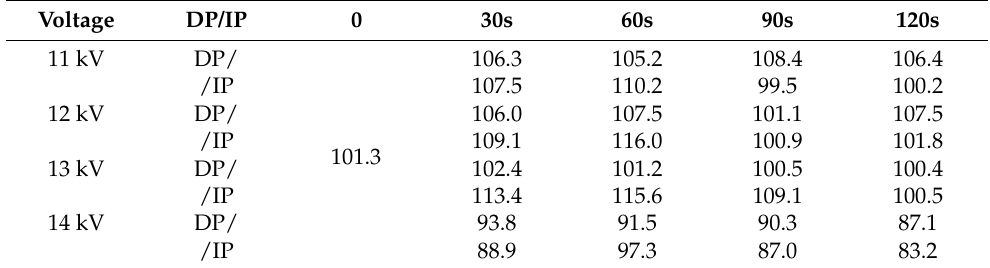
Table 1. Water contact angle of cress seeds treated in different conditions: without cover and with cover.